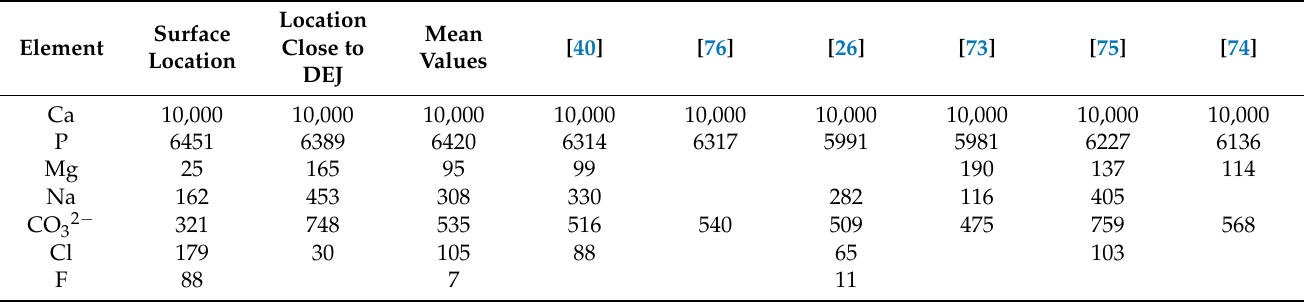
Table 2. Elemental content of the enamel compared with data according Wilson et al. [40], Aoba and Moreno [73], Driessens [26], Hendricks and Hill [74], Teruel et al. [75], Combes et al. [76].